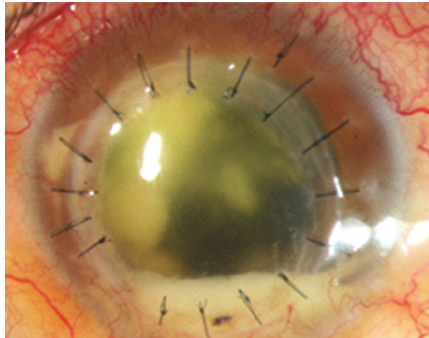
Figure 13: In the same case, in Figure 14, after corneal transplant for visual acuity reason, the patient developed endophthalmitis